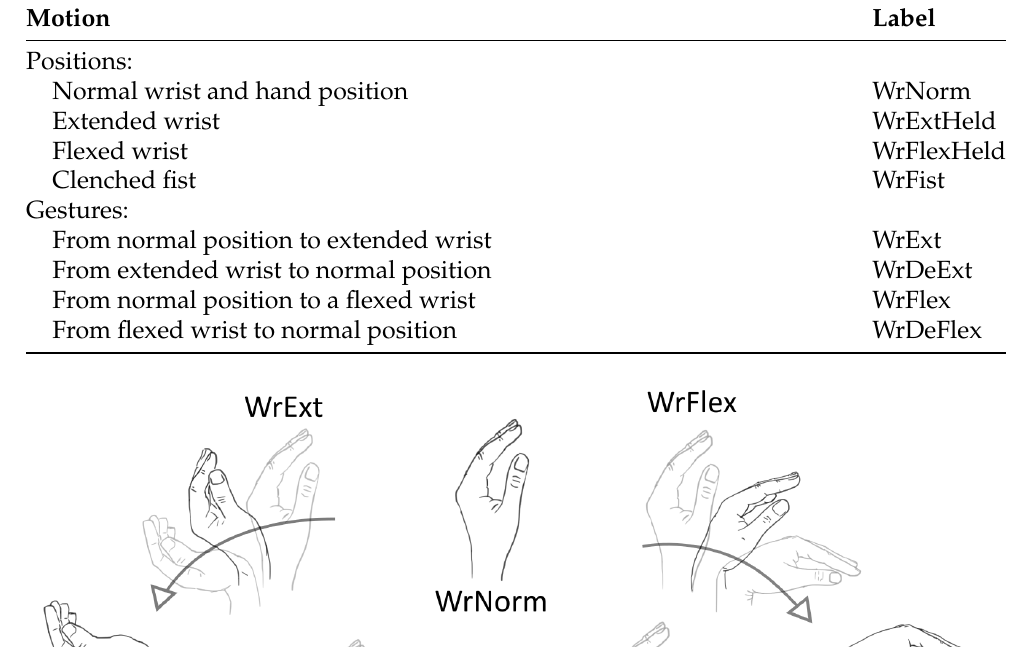
Table 1. The hand motions (positions and gestures) used in the classification tasks and their respec- tive labels.